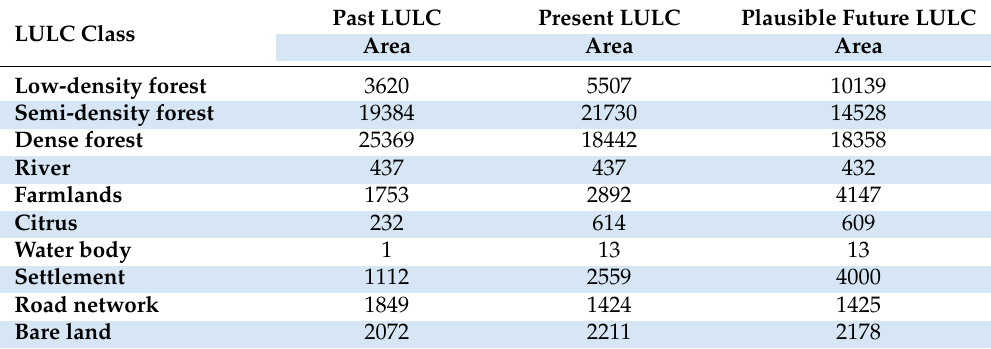
Table 1. The area (ha) of each LULC classes under past, present, and plausible future situation.